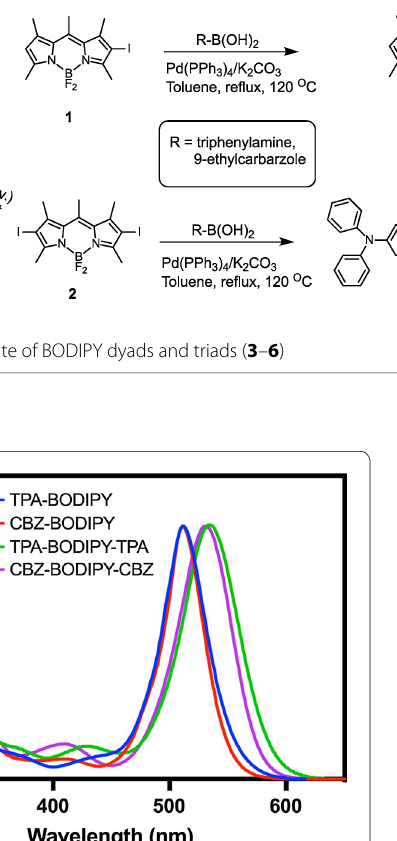
(E ox 4.8) [23] = − + g , opt = LUMO − HOMO